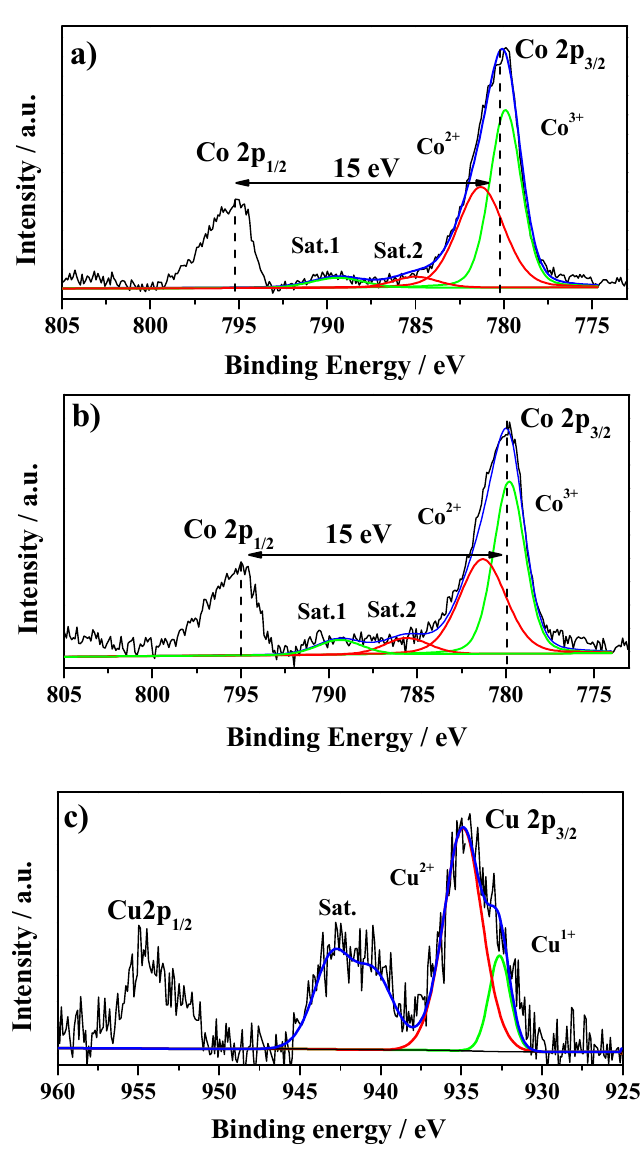
Figure 3. X-ray photoelectron spectra of Co 2p for ( a ) Co 3 O 4 and ( b ) CuCo 2 O 4 , and ( c ) Cu 2p for CuCo 2 O 4 . Table 2. Binding energies of Co 2p and Cu 2p and surface composition obtained from X-ray